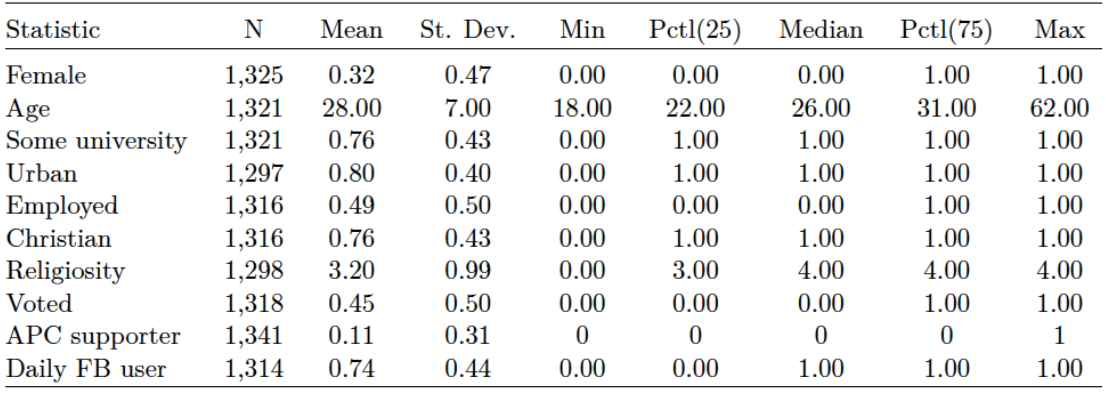
Table A1. Descriptive statistics of study respondents.